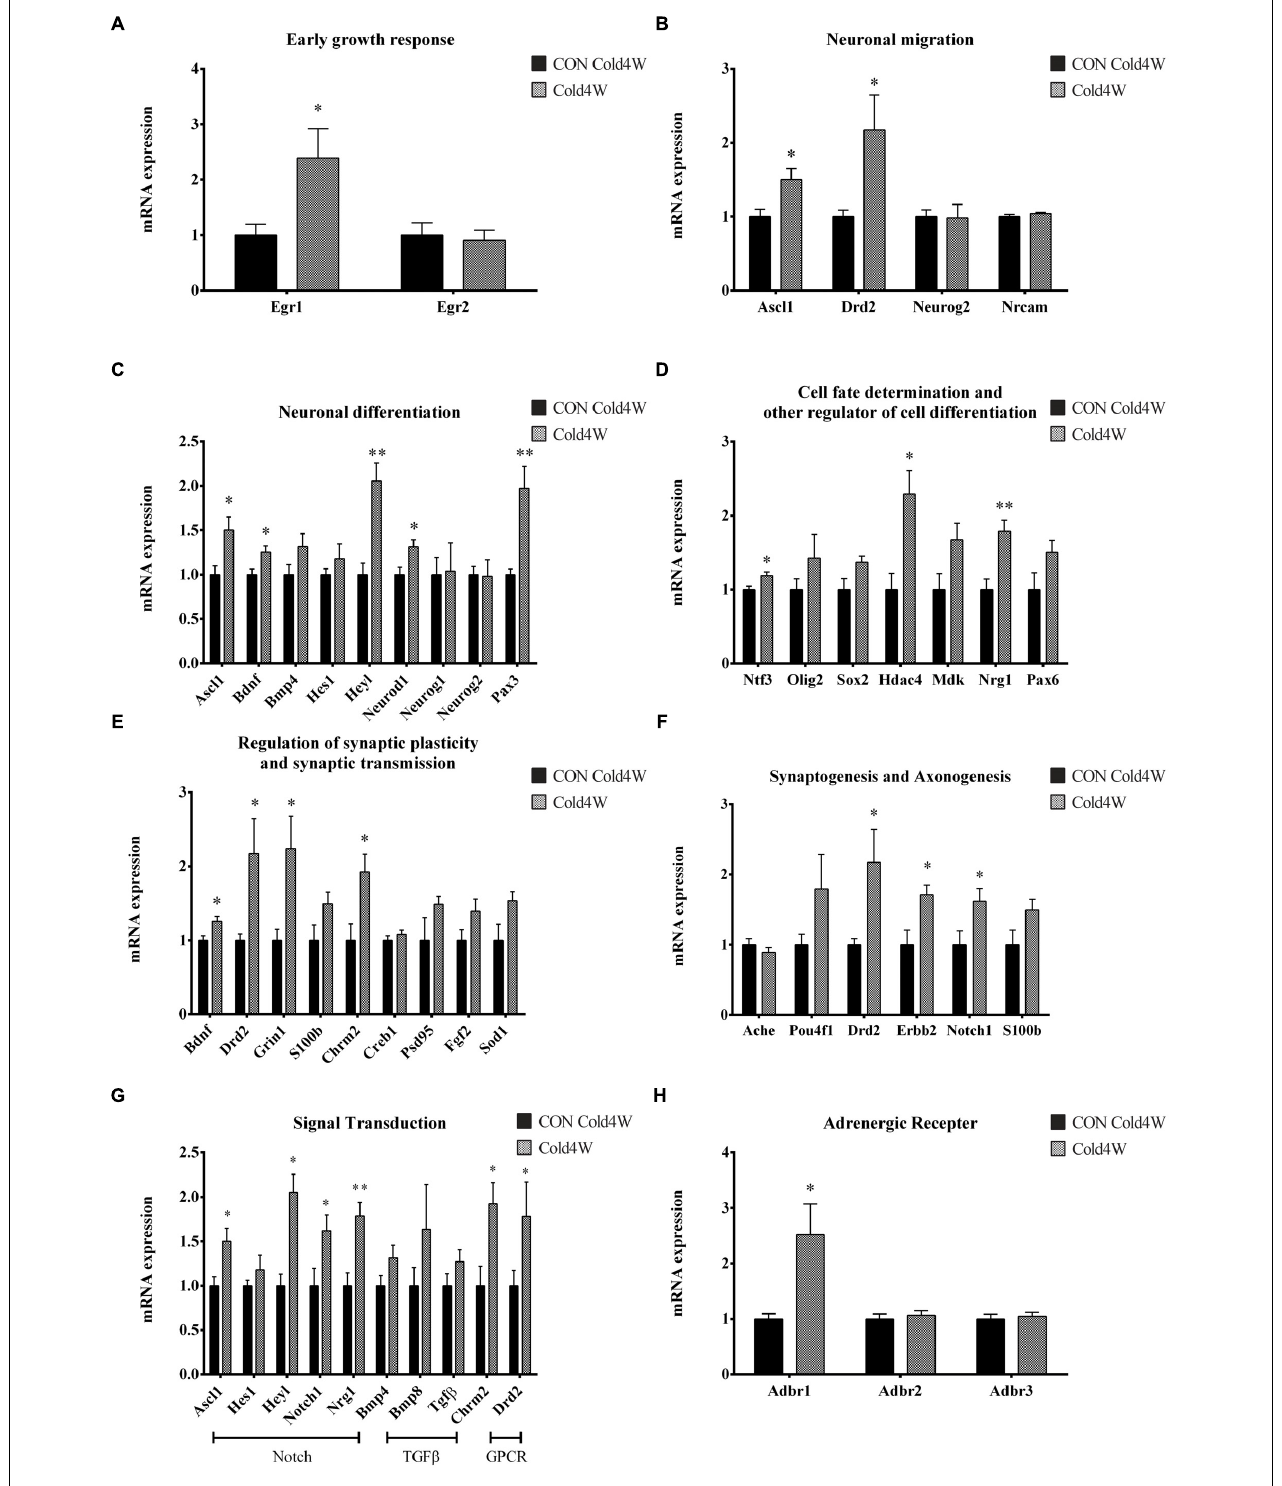
FIGURE 6 | Effects of 4 weeks cold challenge on the expression levels of mRNA related to AHN, AHN-related signal transduction, and β -adrenergic receptor. Cold challenge for 4 weeks increases several genes related to (A) early growth response, (B) neuronal migration, (C) neuronal differentiation, (D) cell fate determination and other regulator of cell differentiation, (E) regulation of synaptic plasticity and synaptic transmission, (F) synaptogenesis and axonogenesis, (G) AHN-related to signaling transduction and (H) β -adrenergic receptor. ∗ indicates a significant difference when compared to the CON group ( p < 0.05); and ∗∗ indicates a significant difference when compared with the CON group ( p < 0.01). Data are shown as mean + SEM.